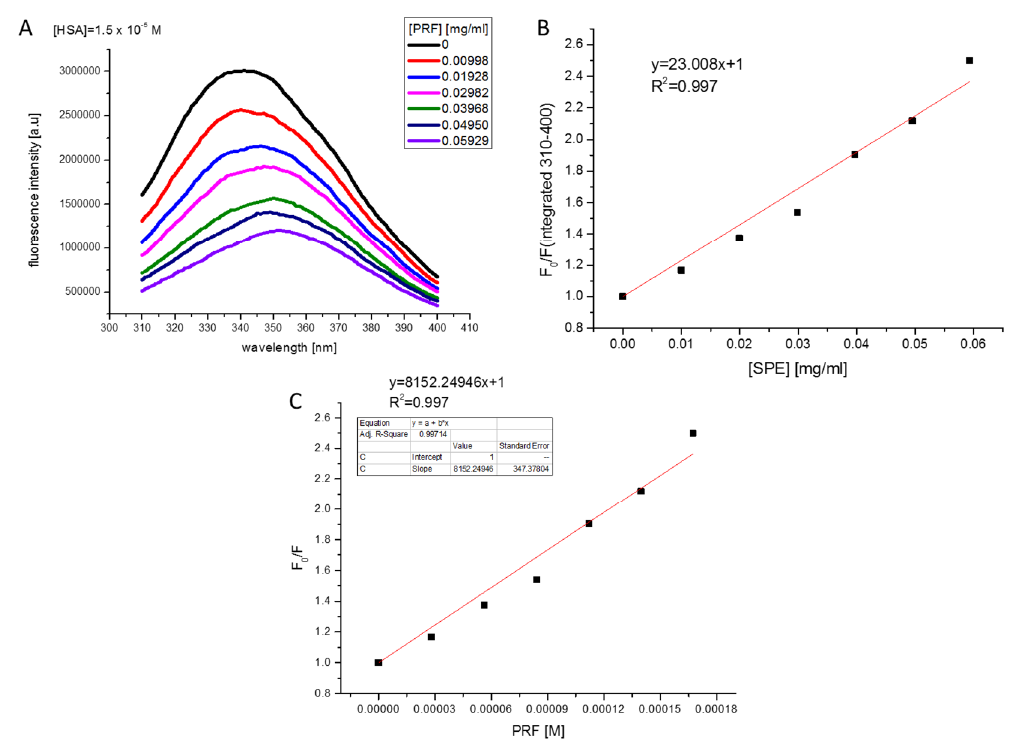
Figure 12. Fluorescence spectrum of HSA (1.5 × 10 − 5 M, excitation at 295 nm) and its changes upon increasing concentrations of the PRF extract ( A ). Stern–Volmer plot for HSA quenching by PRF (concentration of PRF in mg / mL) ( B ). Stern-Volmer plot for HSA quenching by PRF (concentration of PRF in expressed as chlorogenic acid equivalent [M]) ( C ).